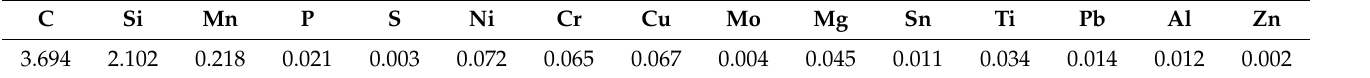
Table 1. Chemical composition of SGI (as % of the weight).